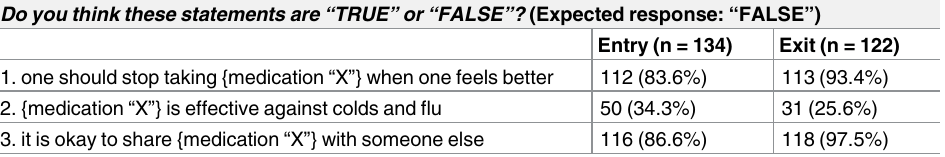
Table 1. Proportion of responses for which respondents responded “FALSE” for a set of true-or-false questions regarding the use of antibiotics. Do you think these statements are “TRUE” or “FALSE”? (Expected response: